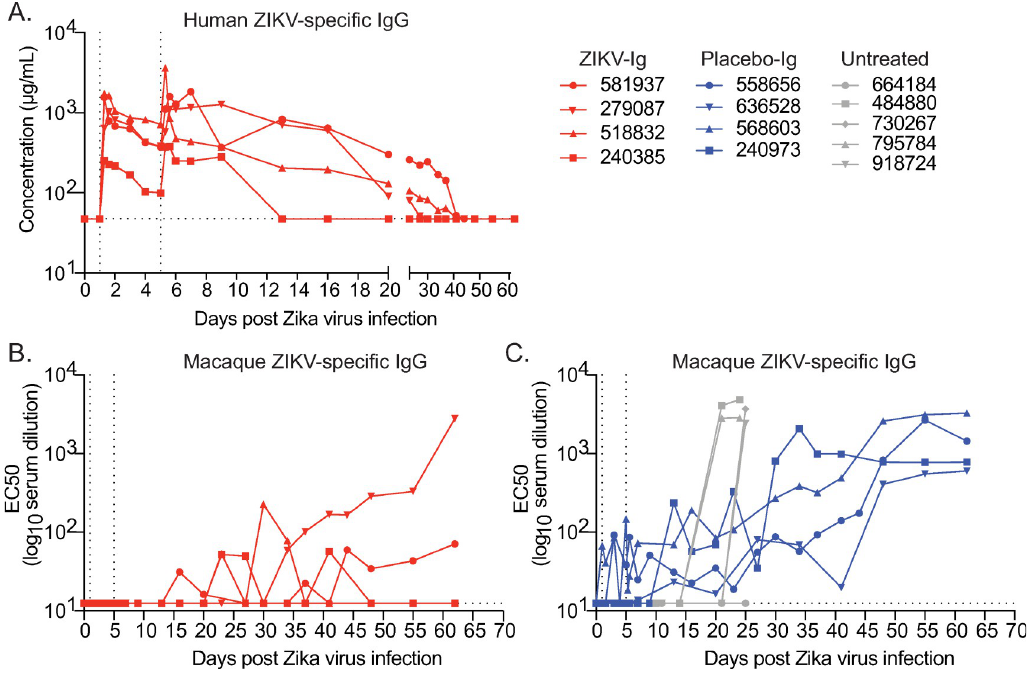
Fig 3. Measurement of human or macaque-specific binding antibody titers by whole virion binding ELISA. (A) Concentration of human ZIKV-specific IgG antibodies measured longitudinally in ZIKV-IG-treated animals. (B) EC50 of macaque ZIKV-specific IgG antibodies in ZIKV-IG-treated animals. (C) EC50 of macaque ZIKV-specific IgG antibodies in placebo-IG and untreated animals. Dotted lines represent the limit of detection for each assay. Vertical dotted lines indicate the time points of IgG